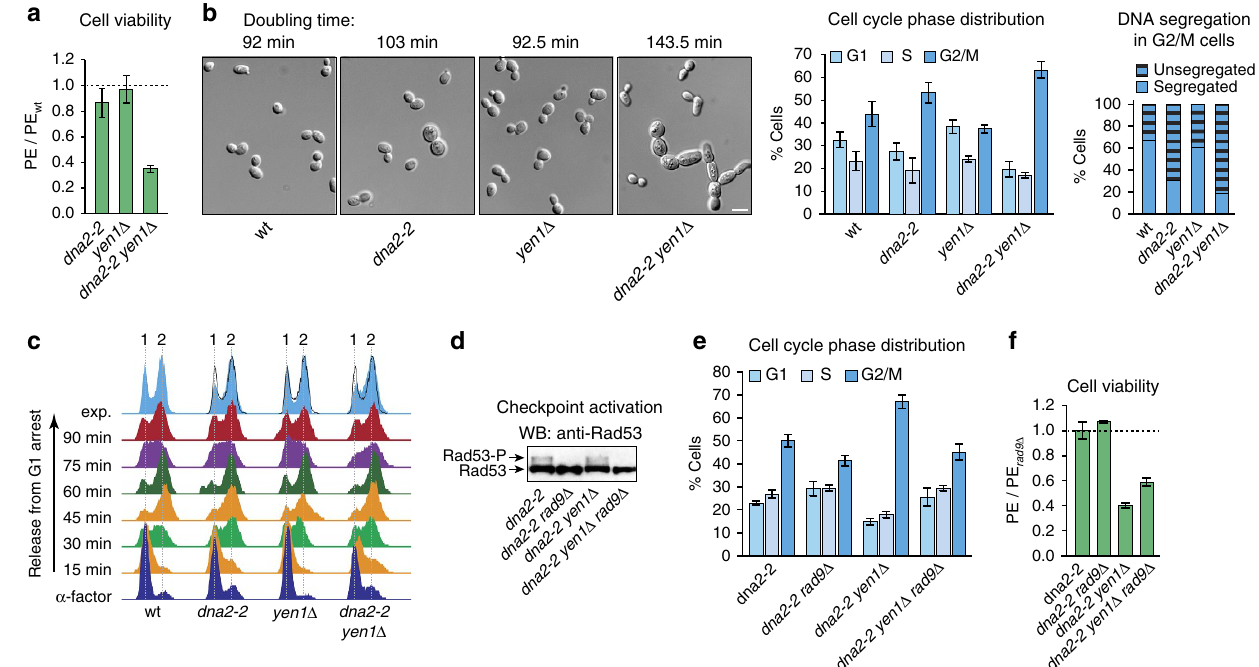
Figure 2 | Dna2 helicase-defective cells suffer dual growth inhibition by checkpoint activation and loss of YEN1 . ( a ) Cell viability of the indicated strains assessed by colony outgrowth. The mean plating efficiency (PE) ± s.e.m. ( n ¼ 3) is presented relative to wild-type. ( b ) Microscopic analysis of the indicated strains growing exponentially in rich medium. Left , representative images (DIC) showing morphological changes associated with Dna2 helicase dysfunction and loss of Yen1. Average doubling times are given ( n ¼ 3). Scale bar, 5 m m. Centre , mean distribution of G1, S, and G2/M cells ± s.e.m. ( n ¼ 4). Right , DNA segregation in G2/M cells as determined by DAPI-staining. An average of 200 cells were scored per strain. ( c ) Flow cytometric analysis of the indicated strains synchronized in G1 using a -factor and released into YPAD. The position of cells with 1 and 2N DNA content is indicated. Topmost tracks are asynchronous cultures overlaid with the outline of the wild-type profile, showing that Dna2 helicase-defective strains accumulate cells with a 2N content over time. ( d ) Western blot analysis showing chronic low-level DNA damage checkpoint activation in Dna2 helicase-defective cells as indicated by Rad53 phosphorylation (Rad53-P). ( e ) Effect of DNA damage checkpoint disruption by deletion of RAD9 on the distribution of G1, S, and G2/M cells in exponentially growing cultures of the indicated strains. Data presented as mean distribution ± s.e.m. ( n ¼ 3). ( f ) Cell viability of the indicated strains assessed by colony outgrowth. The mean plating efficiency ± s.e.m. ( n ¼ 3) is presented relative to a rad9 D